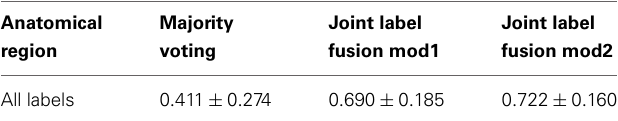
FIGURE 9 | Joint label fusion performance (Left: segmentation accuracy, error bars at ± 0.05 standard deviation; Right: average processing time) with respect to local search neighborhood size. Other parameters are set to r p = 2 , α = 0 . 1 , β = 0 . 5. Table 2 | Segmentation performance in Dice Similarity Coefficient (cid:2) (cid:3) 2 | A ∩ B | produce by leave-one-out cross validation using the canine | A |+| B | leg muscle training